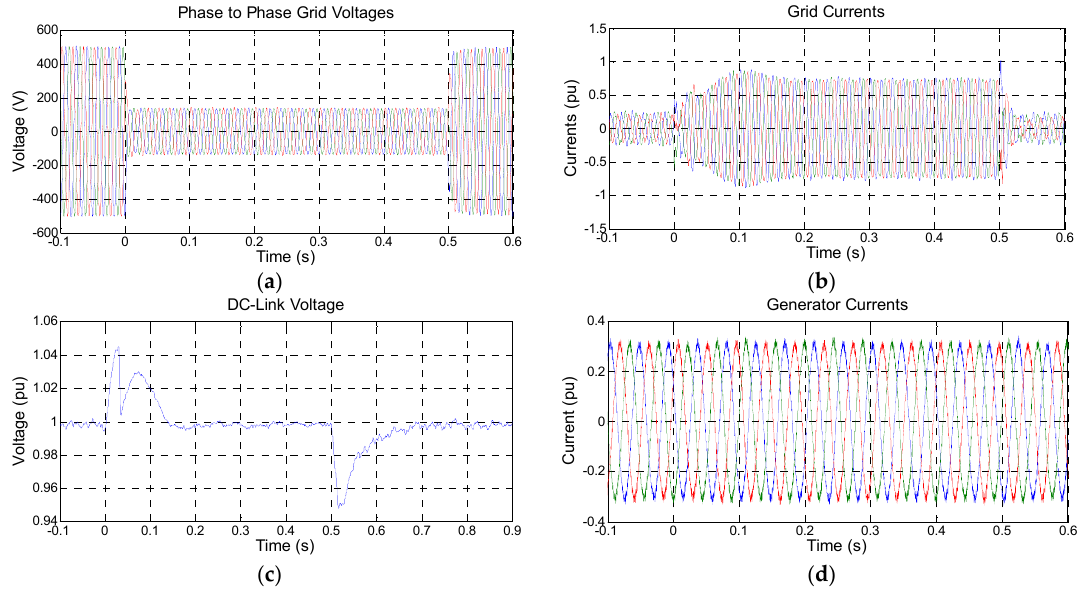
Figure 7. Experimental results for 25% three ‐ phase voltage sag with the system operating with 20% of rated power: ( a ) grid voltages; ( b ) grid currents; ( c ) DC ‐ link voltage; and ( d ) generator currents.